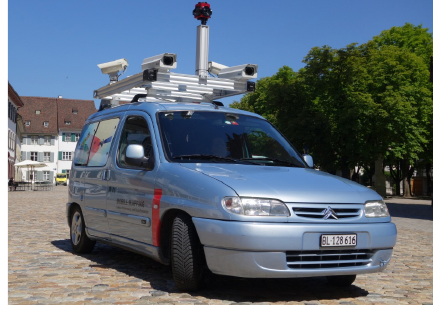
Figure 1. IVGI mobile mapping system